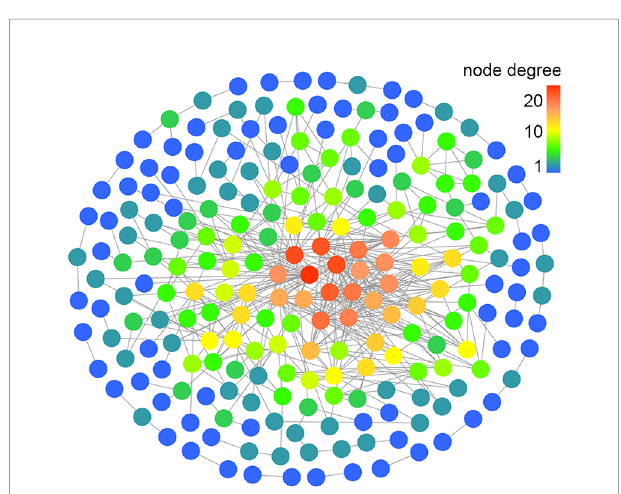
FIGURE 3 | Correlation network of the shrimp transcriptome. The relationship among all genes was estimated by Spearman's correlation analysis. And those with low correlated (|r| < 0.7) are not